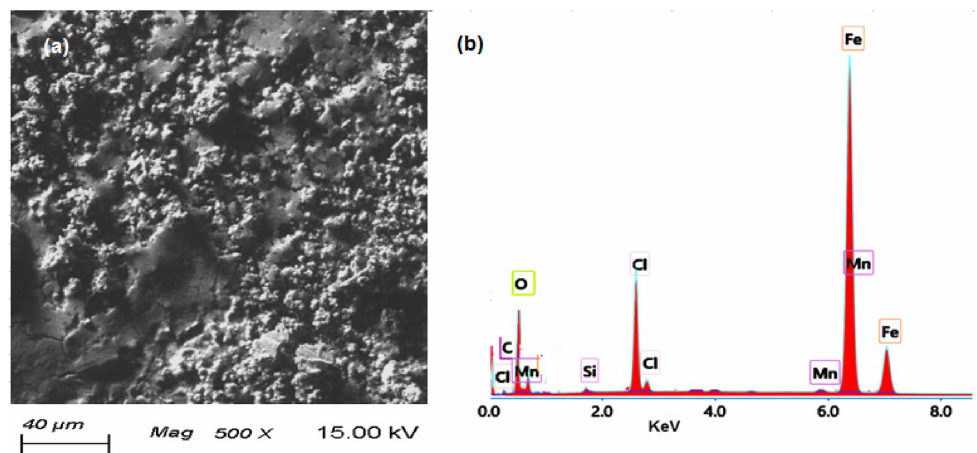
Figure 8. ( a ) SEM image and ( b ) EDX spectra for N80 C-steel pipe after immersion in the blank solution (15.0%